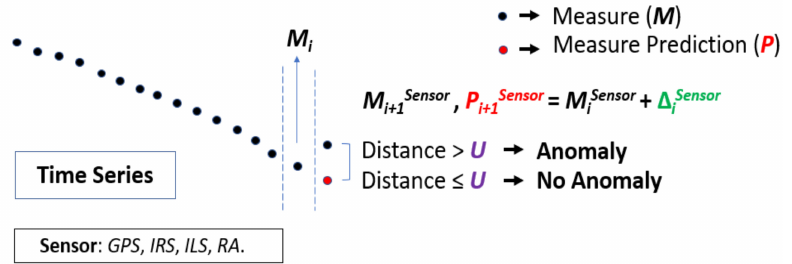
Figure 4. Main elements and basic behavior of NADCA. The red dot at time i + 1 is the measure prediction. Algorithm 1: NADCA-B